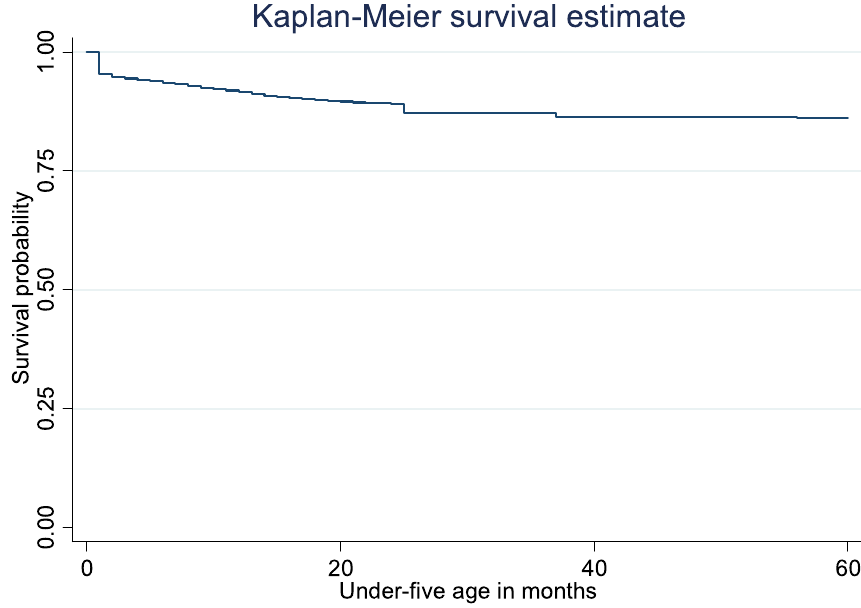
Figure 2. Plot of the overall estimate of the Kaplan–Meier survivor function of under-five mortality in Nigeria.